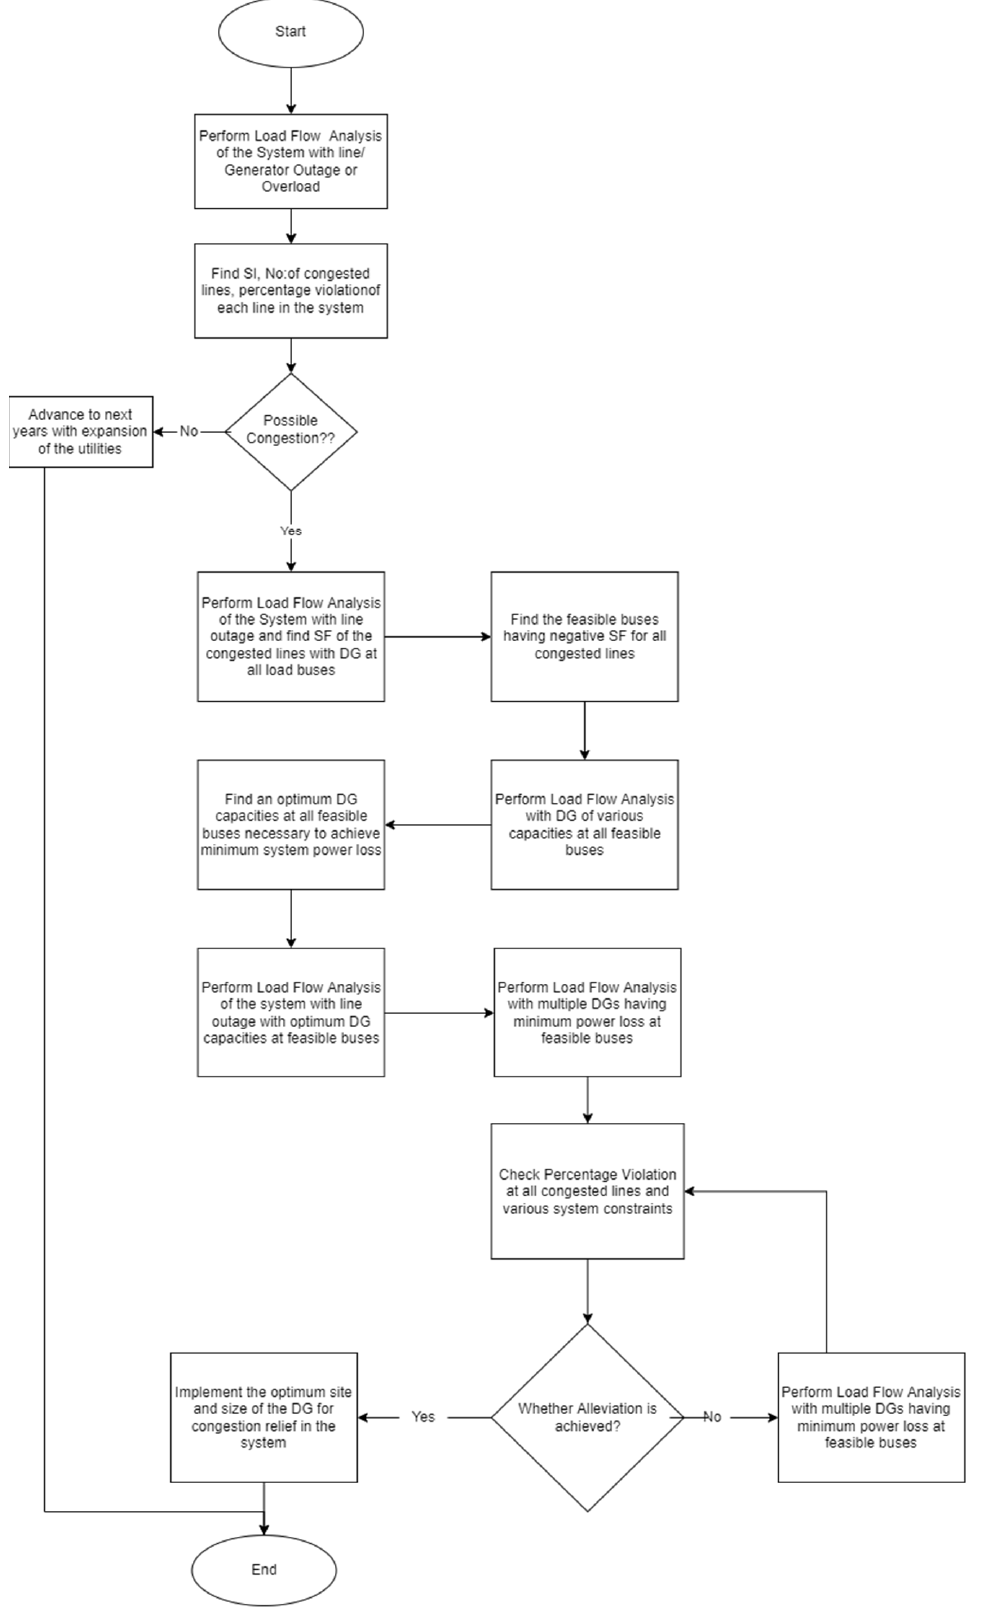
Figure 4. Algorithm for managing congested feeders in interconnected transmission networks of any bus system with DG penetration.